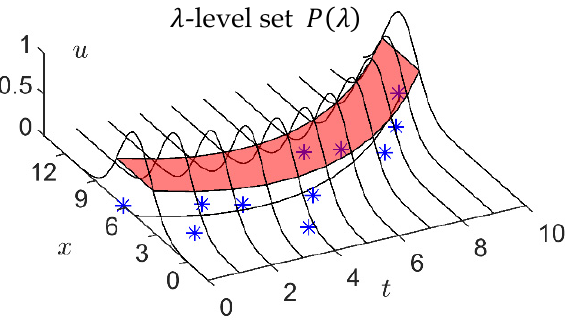
Figure 5. The 𝜆 -level set of a PFIG. Figure 5. The λ -level set of a